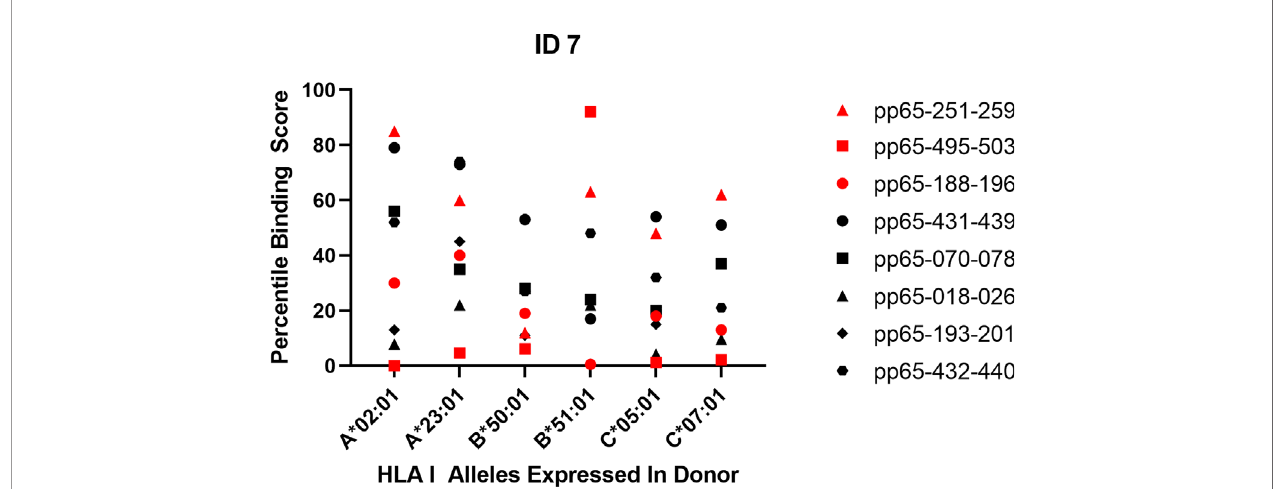
FIGURE 1 | Predicted vs. actual pp65 epitope recognition by CD8+ T cells. Data are shown for subject ID 7 expressing the speci fi ed HLA alleles and responding to the listed peptides. Super-dominant responses are shown as red data points, dominant responses in black and weaker responses are not represented. The raw data for the peptide-induced SFU counts are listed in Table 1 . The corresponding Percentile Binding Score as established by the netMHCIpan search engine is shown comparing a peptide ’ s binding relative to the binding scores computed for 1,000 random nonamer peptides. A lower percentile binding score denotes better peptide binding to the speci fi ed HLA